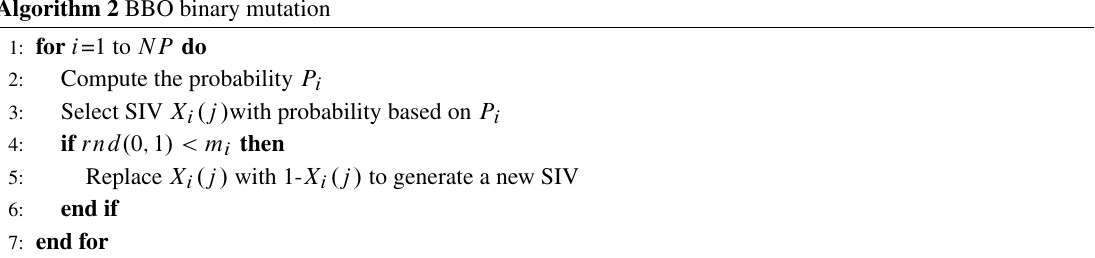
Algorithm 2 BBO binary